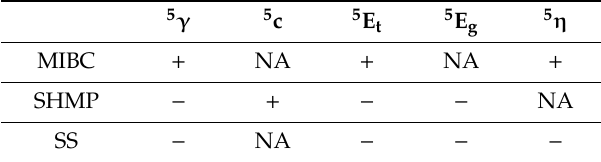
Table 5. Covariance of the statistically significant factor–response variable pairs ( τ = 5